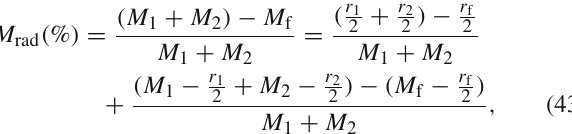
approximates the minimum value of M 1 for small γ .